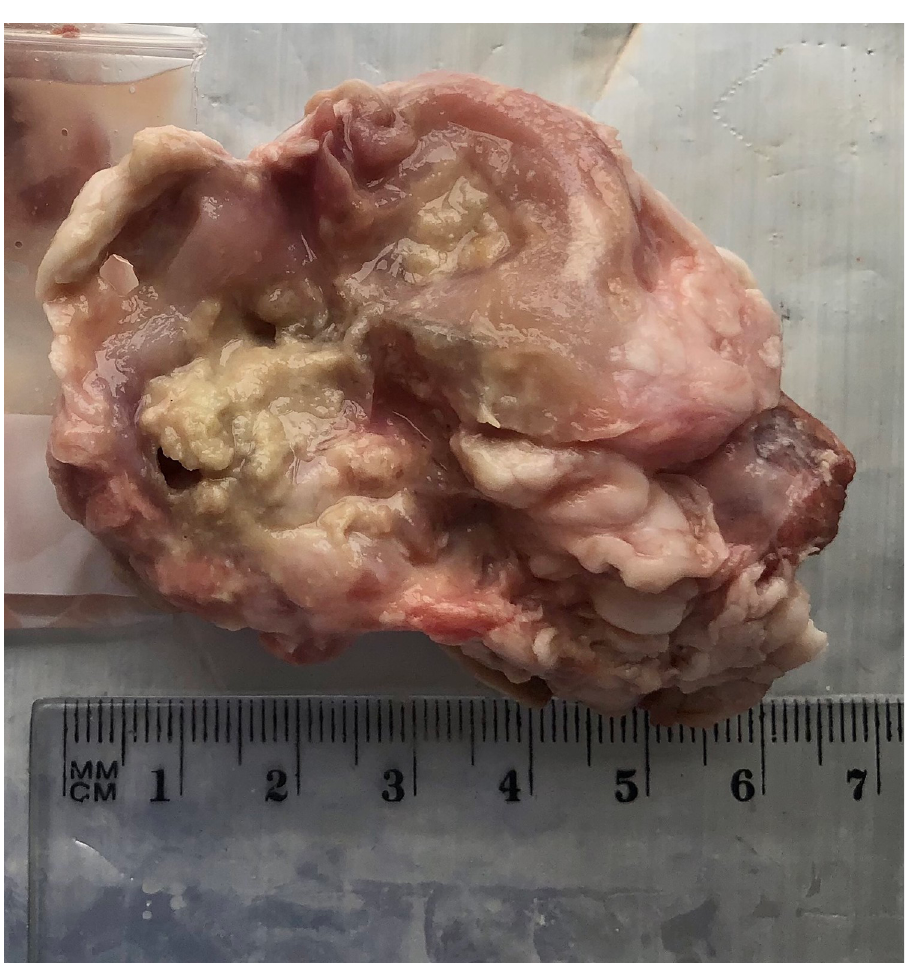
Fig 3. Mandibular lymph node with numerous pinhead-size lesions,